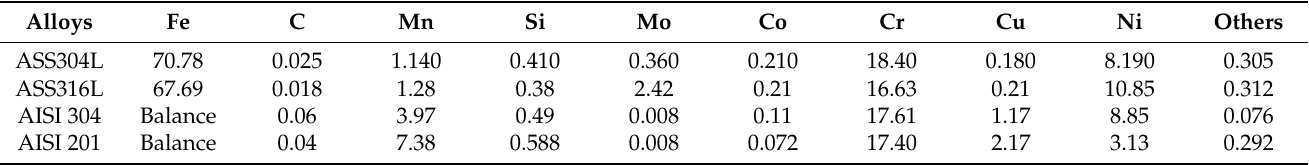
Table 7. Elemental composition of some austenitic alloys, reprinted with permission from refs. [36,46]. Copyright 2018 Elsevier Ltd. Alloys